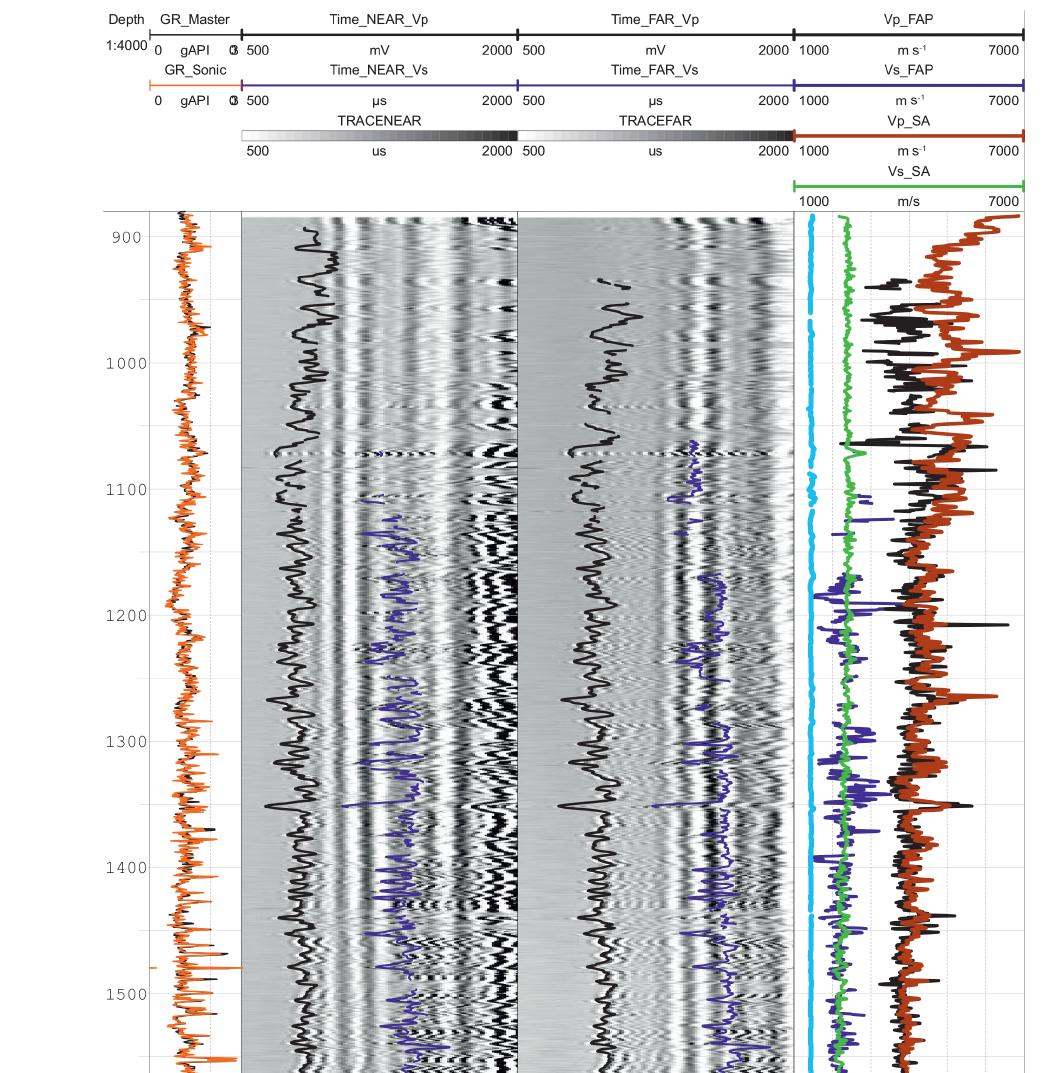
Figure 4. Example of raw borehole sonic waveform data analysis from PTA2. Near- and far-receiver traces (50cm spacing) with first arrival picking (FAP) results. The derived velocities are shown on the right side together with results from a separate semblance analysis (SA). The light-blue curve is the measured water wave velocity, and total GR is shown for depth